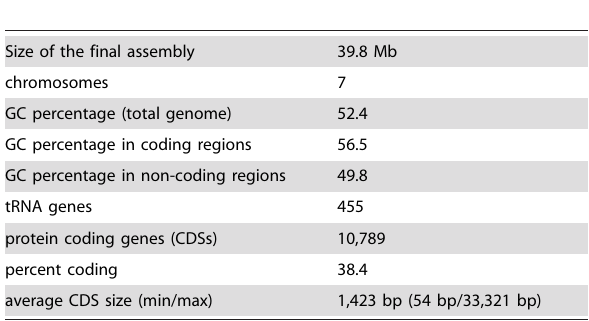
Table 3. Main features of the S. macrospora genome sequence.